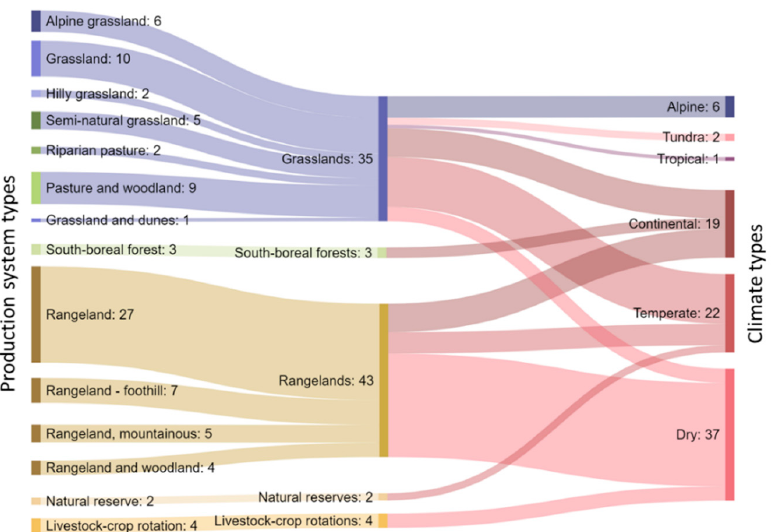
Figure 3. Number of production systems and climate types on the study sites from the 84 studies (87 experiments in total) published between 2000 and 2020 on the use of GPS tracking on cattle to determine the factors affecting their site use preference on grazing systems.